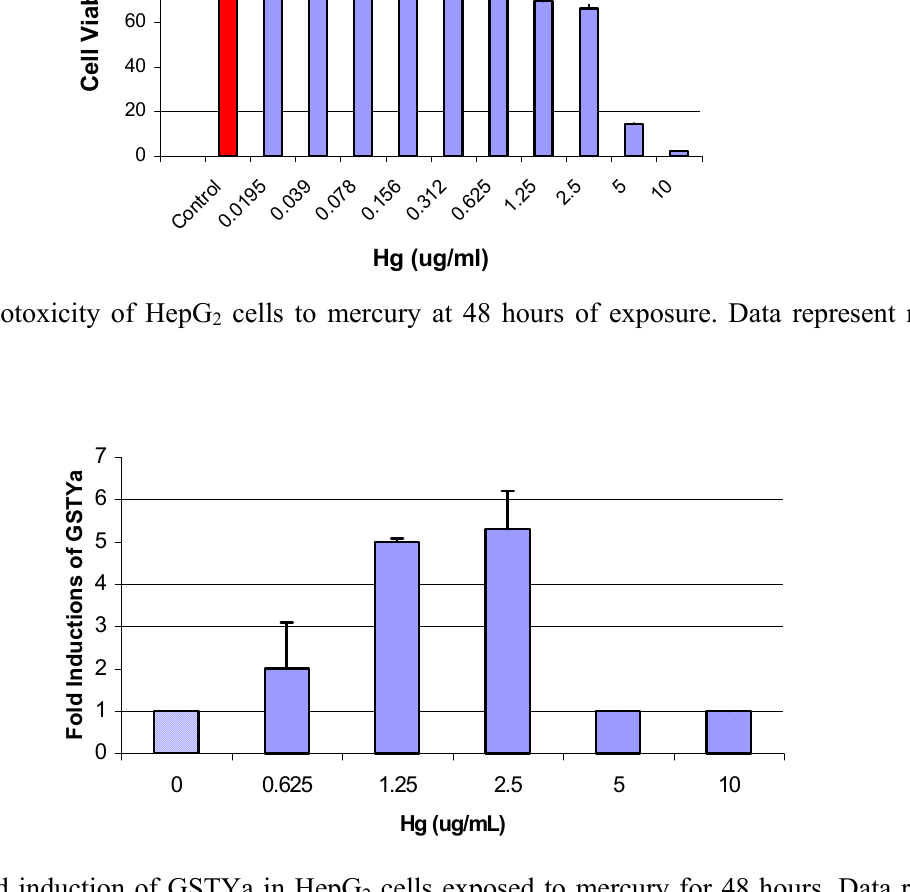
Figure 2. Fold induction of GSTYa in HepG means ± SDs, n = 3.